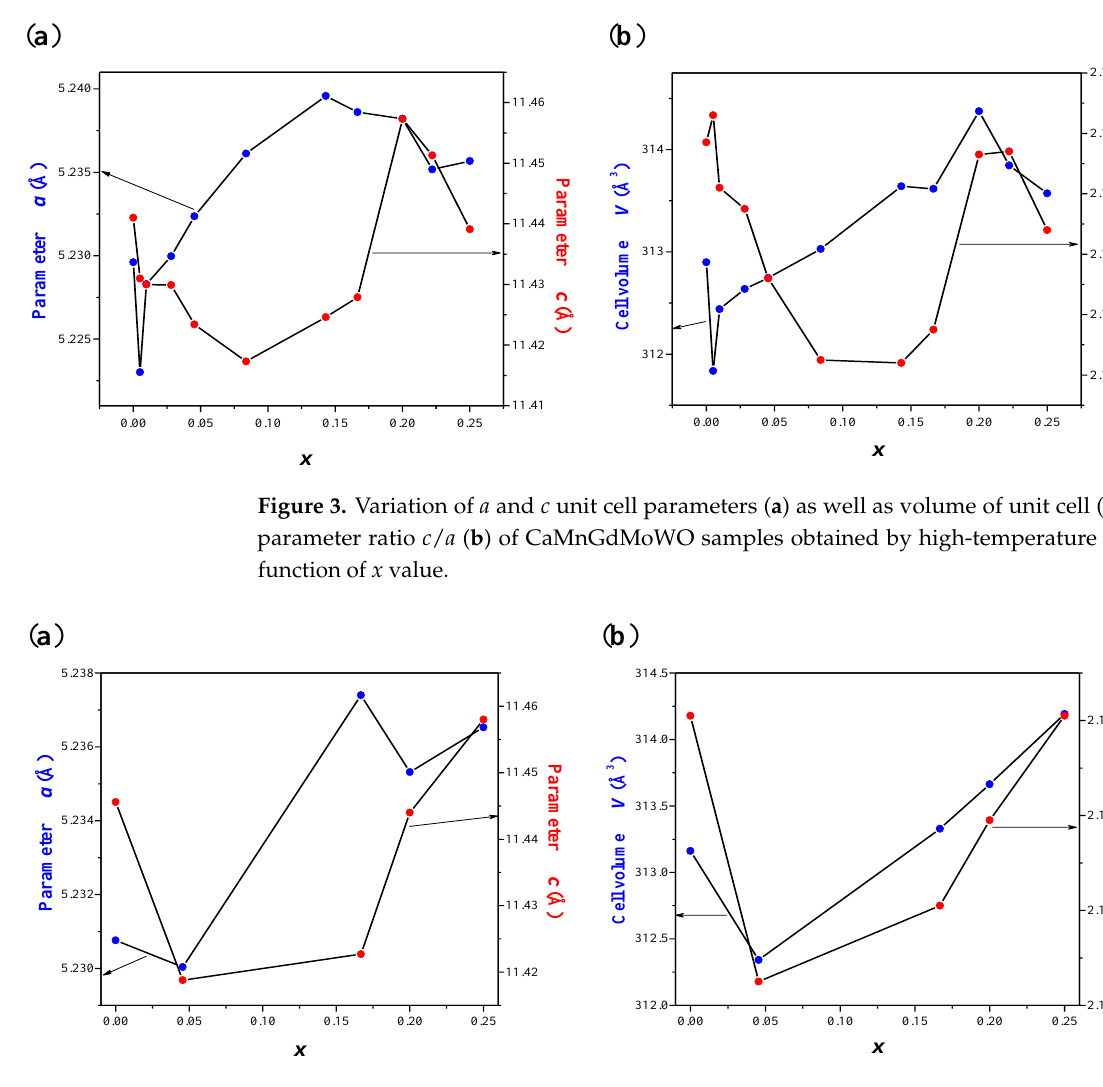
Figure 4. Variation of a and c unit cell parameters ( a ) as well as the volume of unit cell ( V ) and lattice parameter ratio c / a ( b ) of CaMnGdMoWO samples obtained by combustion route as a function of x